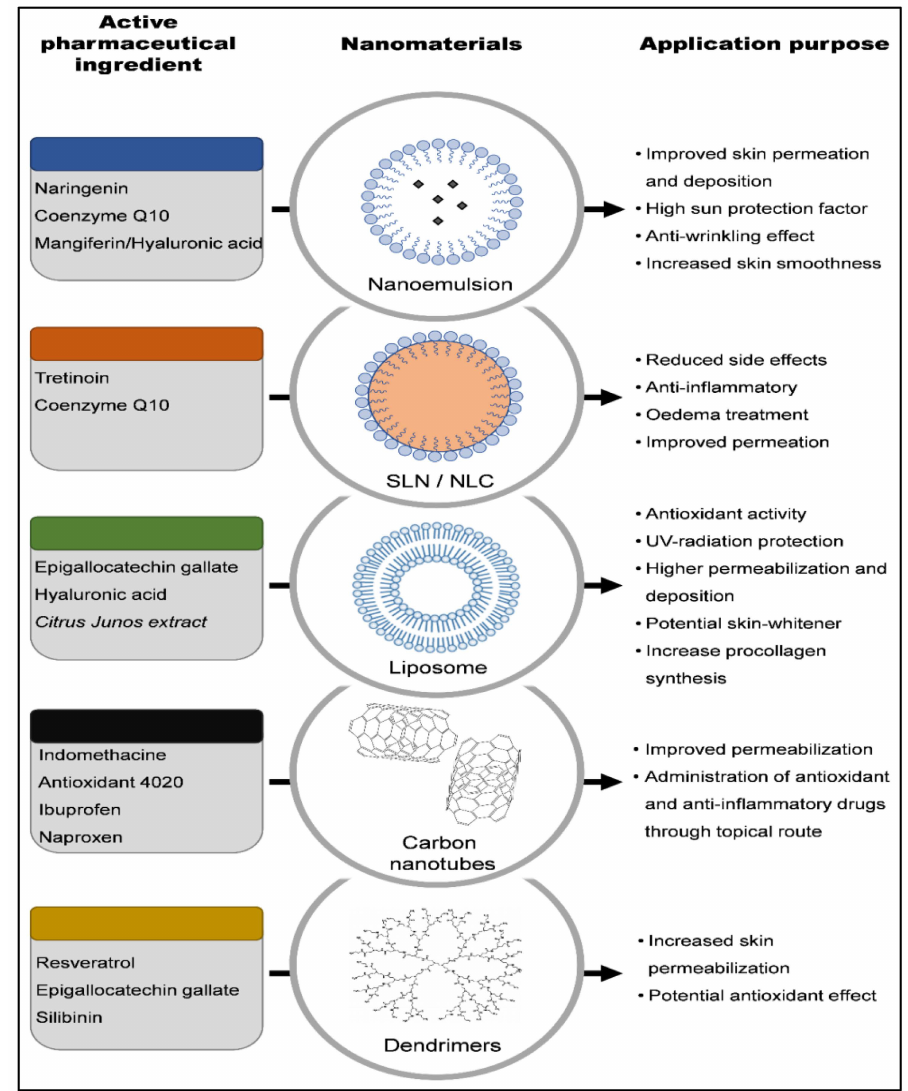
Figure 3. Illustration of nanomaterials that have been utilized to encapsulate a variety of active pharmaceutical ingredients, along with their applications [28]. SLN: Solid lipid nanoparticles; NLC: nanostructured lipid